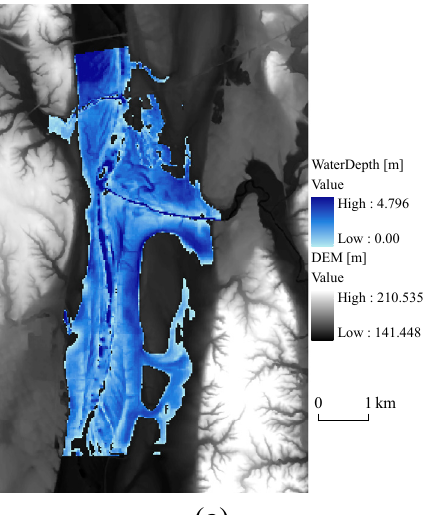
Figure 9. The simulated flood inundation maps for the approximated discharge (50% of CDF based on EF likelihood measure). ( a ) Montezuma (Q = 1245 m 3 /s); ( b ) Nebraska (Q = 5413 m 3